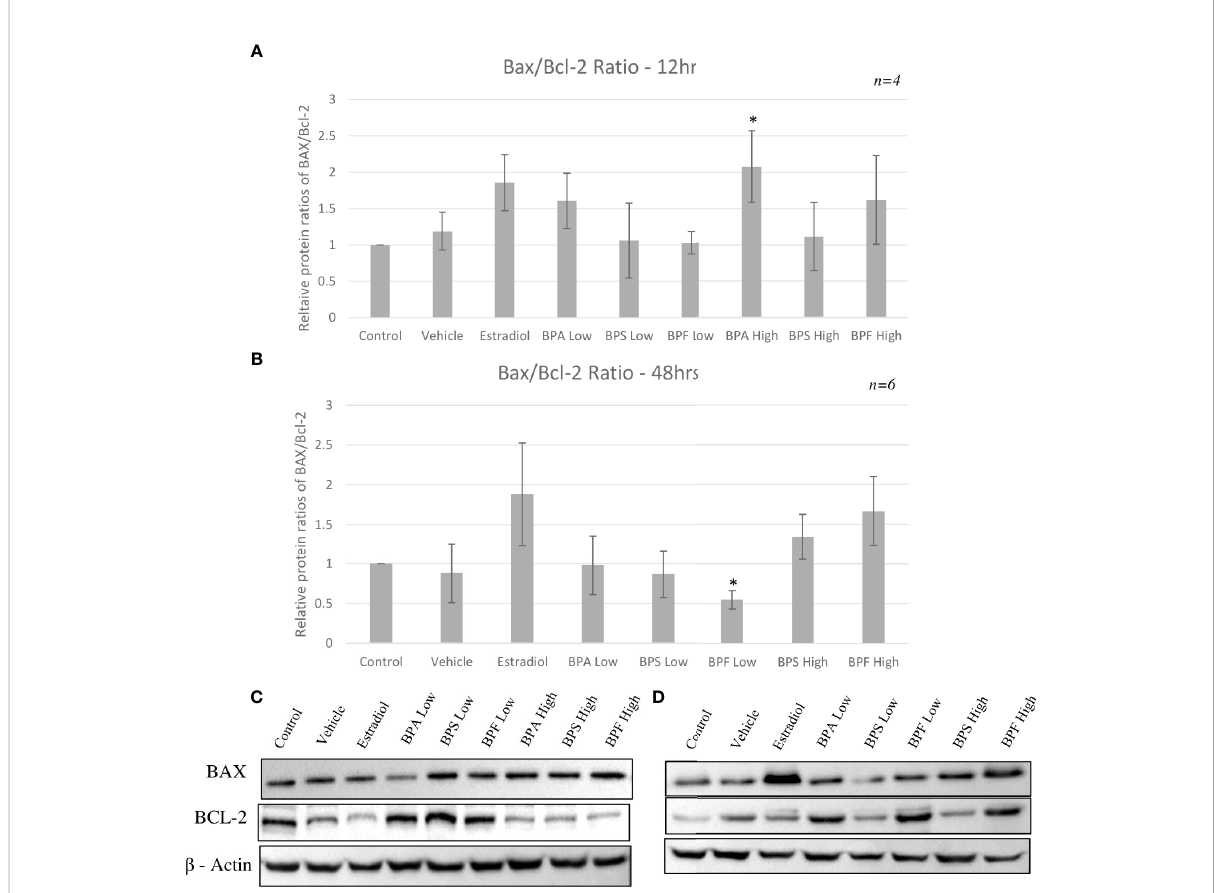
FIGURE 8 Protein ratios of pro-apoptotic BAX and anti-apoptotic BCL-2. Expression was normalized relative to b -actin and was quanti fi ed after bisphenol treatment with BPA, BPS and BPF at 0.5 m g/ml and 50 m g/mL. Ratios were then calculated to obtain the proportion of BAX to Bcl-2 in the same biological samples after (A) 12 hours and (B) 48 hours. Blots represent BAX, BCL-2, and B-actin at (C) 12 hours and (D) 48 hours. *p<0.05 compared to controls was considered as statistically signi fi cant. Error bars represent +/-